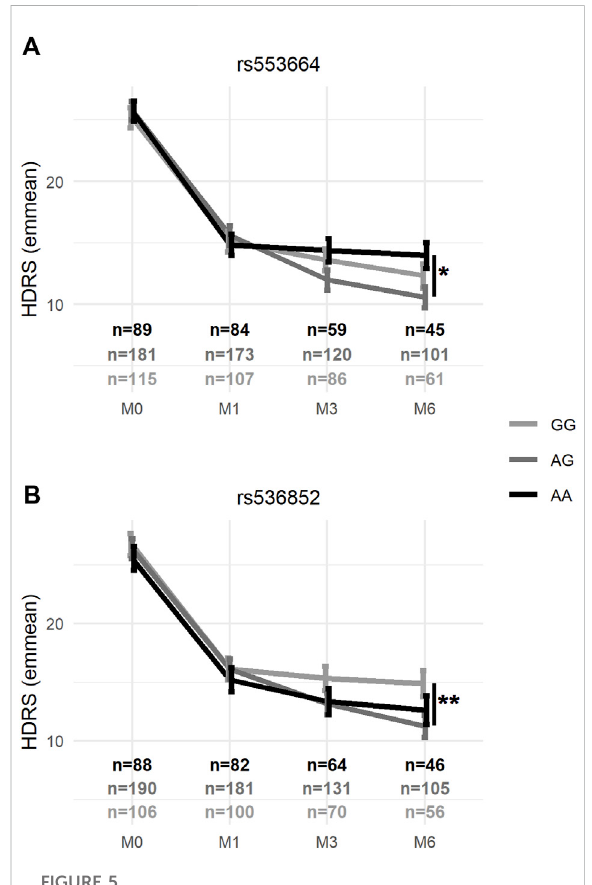
FIGURE 5 Average HDRS scores according to rs553664 and rs536852 genotypes over the course of antidepressant treatment. Average HDRS scores ( y -axis) according to rs553664 (A) and rs536852 (B) genotypes (see legend) are shown across time ( x -axis) after controlling for age, sex, antidepressant class, ethnicity, and signi fi cantly different demographic factors (see Supplementary Table S3). Error bars correspond to the standard error estimates from mixed-effects models. *: p < 0.0056 (0.05/9) **: p < 0.0011(0.01/9).HDRS,17-itemHamiltonDepressionRating Scale; M0, baseline, prior to beginning antidepressant treatment; M1, 1 month after beginning antidepressant treatment; M3, 3 months after beginning antidepressanttreatment;M6,6 months after beginning antidepressant treatment.